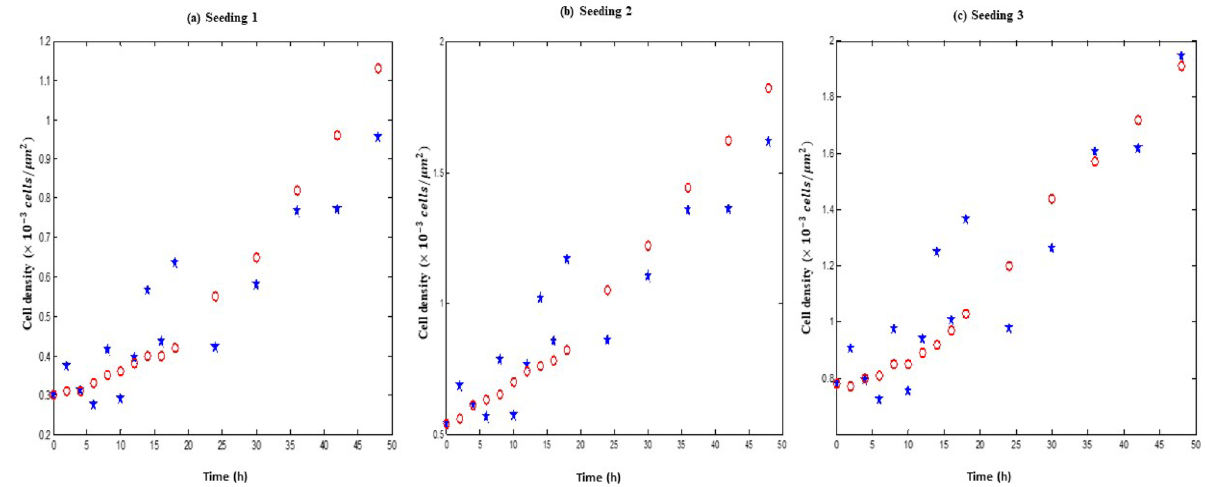
Figure 8. The red dots ( o ) in each sub-figures represent the experimental data of Jin et al. 1 . The blue dots ( are obtained from the stochastic model (3) considering: ( a ) The seeding 1 estimated model parameters with 0.06 and (cid:31) D 0.002 , Q 0.4 . ( b ) The seeding 2 estimated model parameters with D = = = (cid:31) 0.6 . ( c ) The seeding 3 estimated model parameters with D =